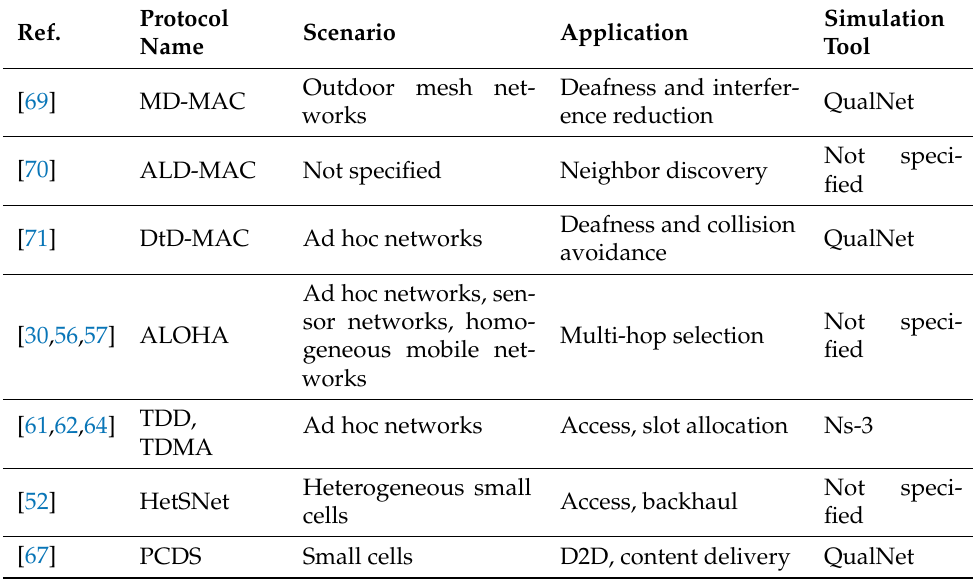
Table 4. Applications of distributed MAC protocols.